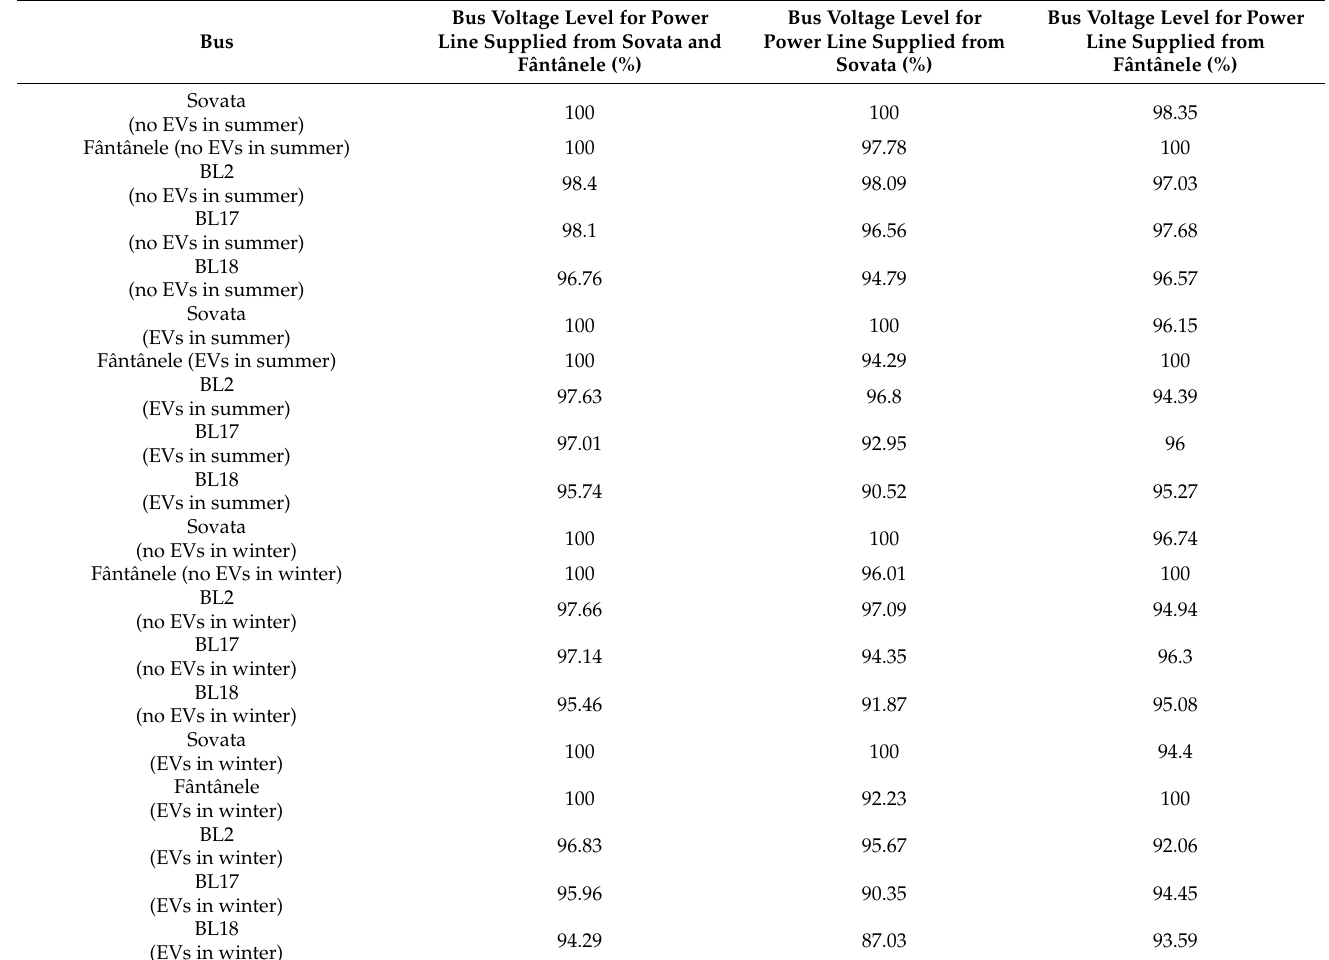
Table 18. Voltage level at 9:00 (scenario 3).